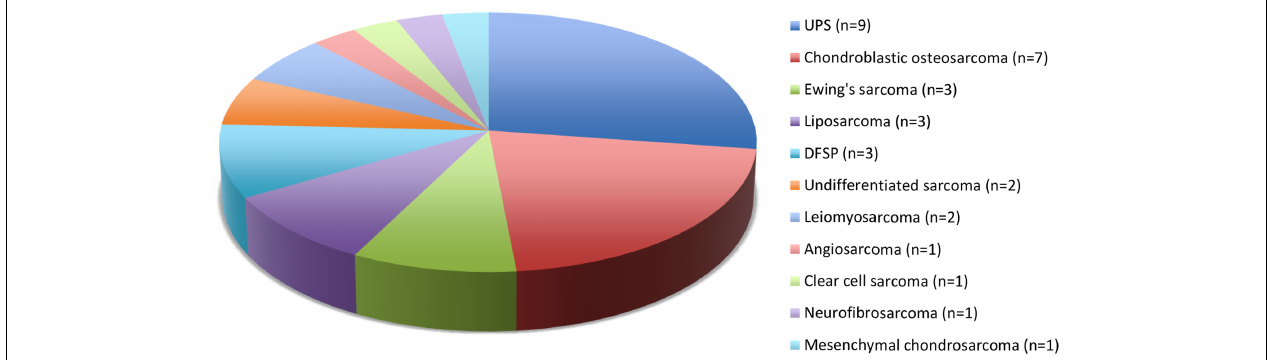
FIGURE 1 | Histological types and numbers of head and neck sarcomas . UPS, undifferentiated pleomorphic sarcoma; DFSP, dermatofibrosarcoma protuberans.